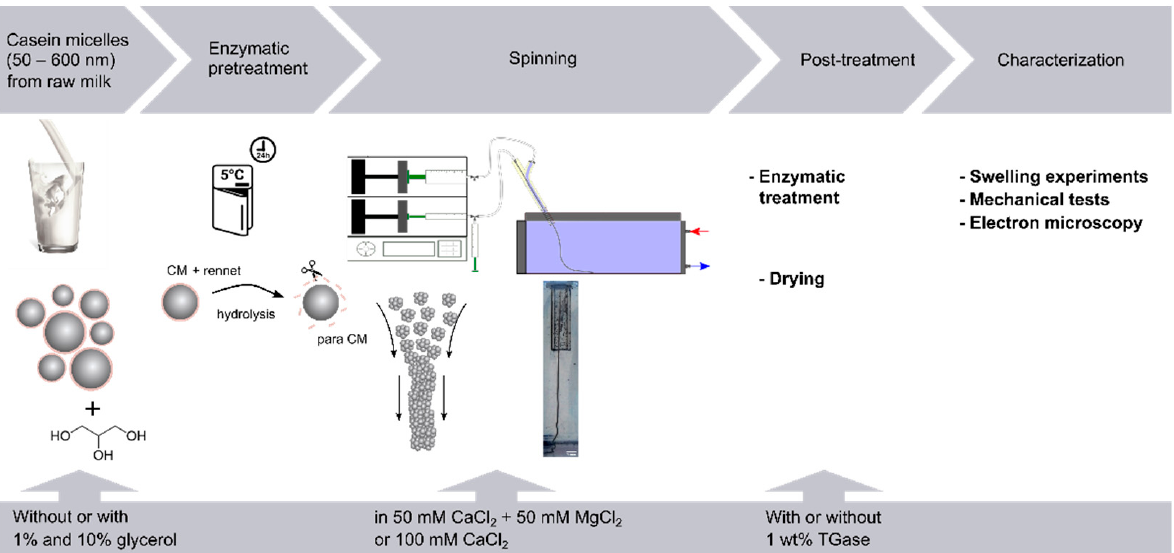
Figure 1. Overview of the reaction mechanism and process of fiber preparation as well as the experimental procedure for preparation and characterization of the fiber.